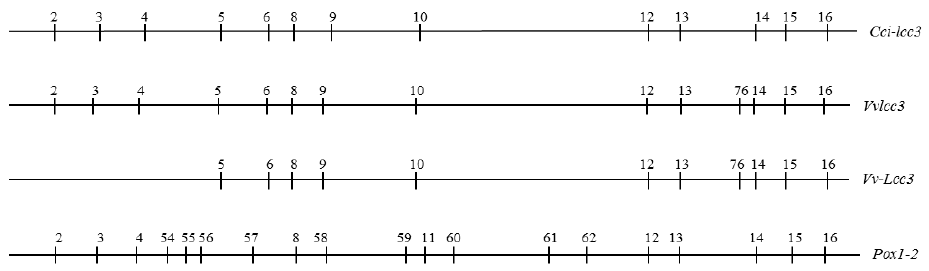
Figure 3. Relative position of introns in different laccase genes; nomenclature of introns referred to Ahlawat 2011 [25]. Cci-lcc3 : C.cinerea lcc3 (AF118269.1); Vvlcc3 : V. volvacea strain PYd21 lcc3 ( KF365491.1); Vv-lcc3: V. volvacea strain VV1 lcc3 (HQ687205); Pox1-2 : P. ostreatus Pox1 (Q12729.1) and Pox2 (Q12739.1)